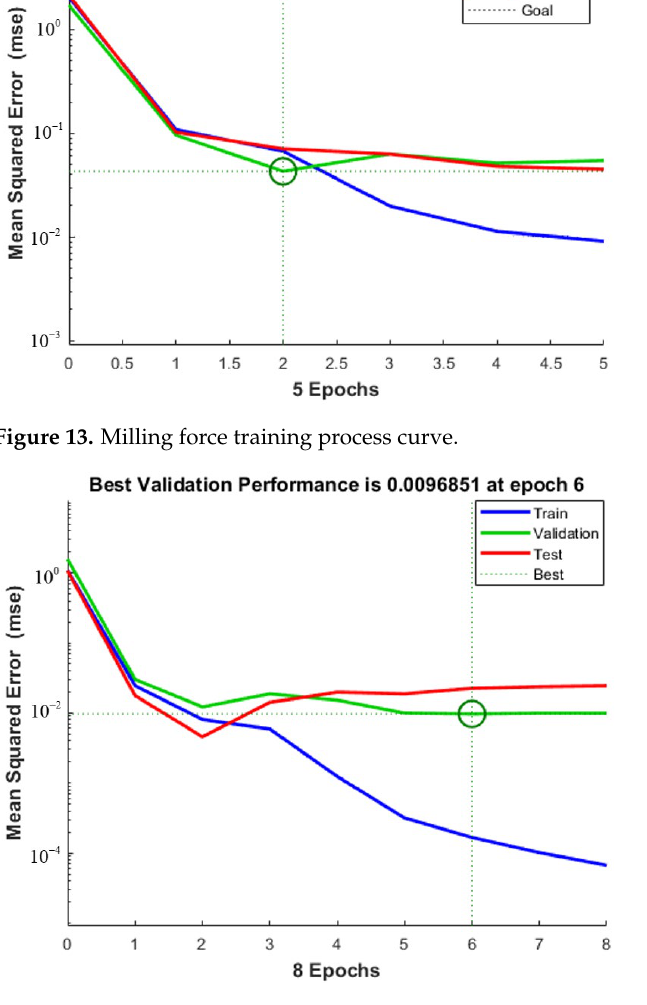
Figure 14. Tool wear training process curve.